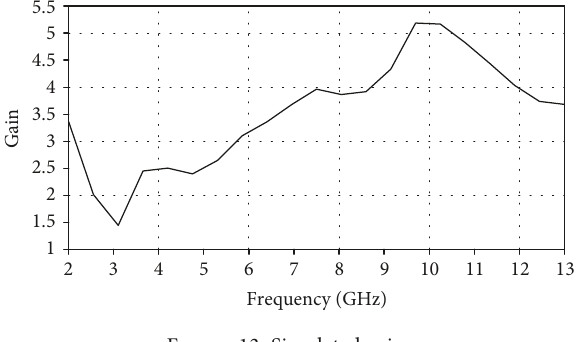
Figure 13: Simulated gain.